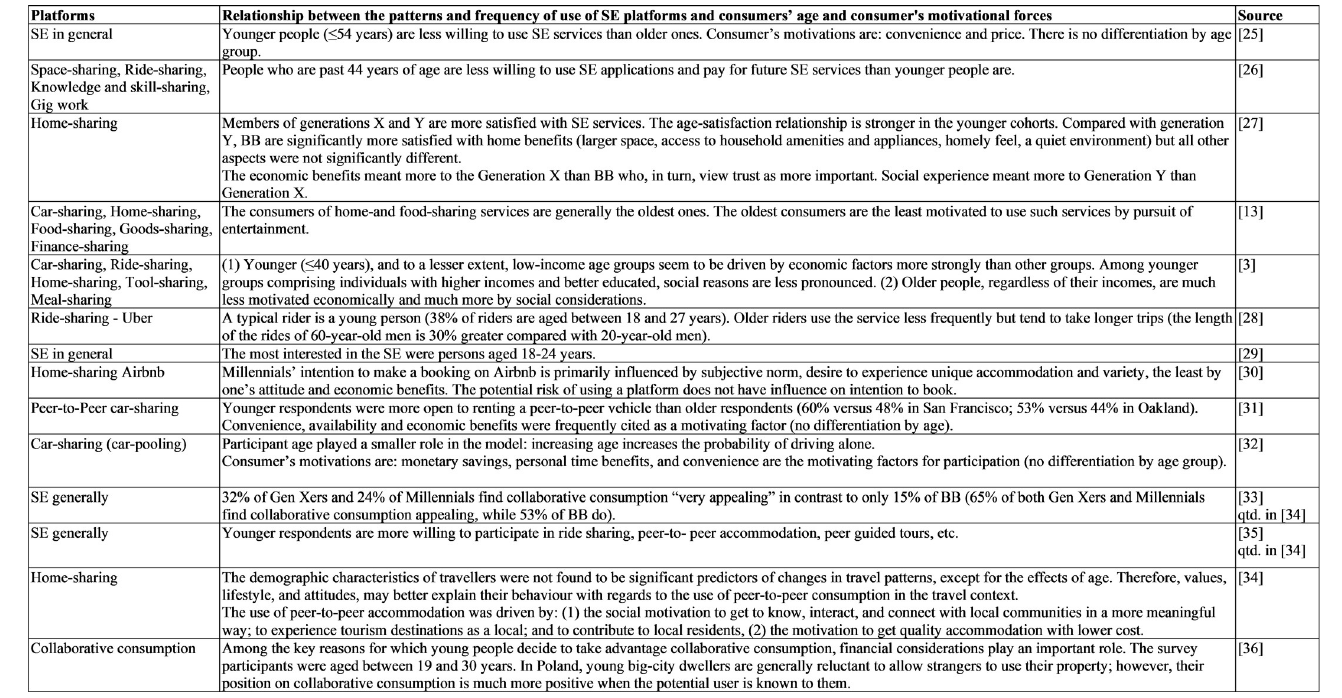
Fig 1. Age and generational membership as factors in the use of SE platforms–an overview of research results [3, 13, 25–36].